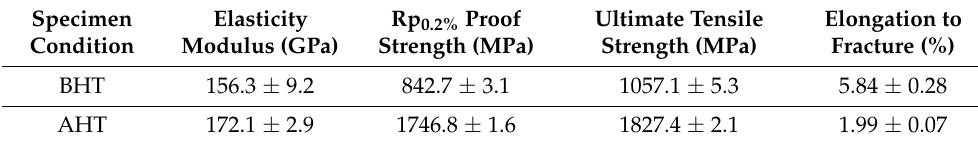
Table 2. Mechanical properties of BHT and AHT samples obtained during tensile testing.